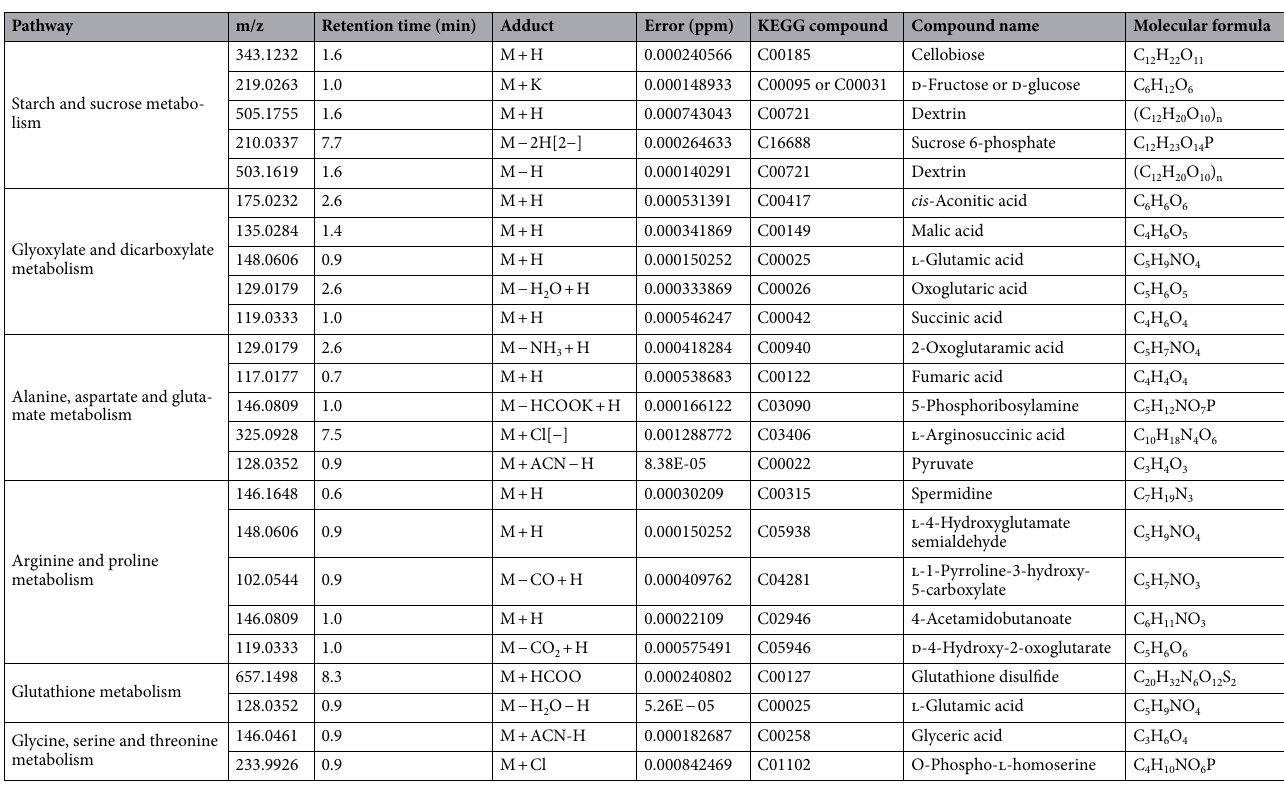
Table 1. The most affected metabolic pathways in drought stress and metabolites